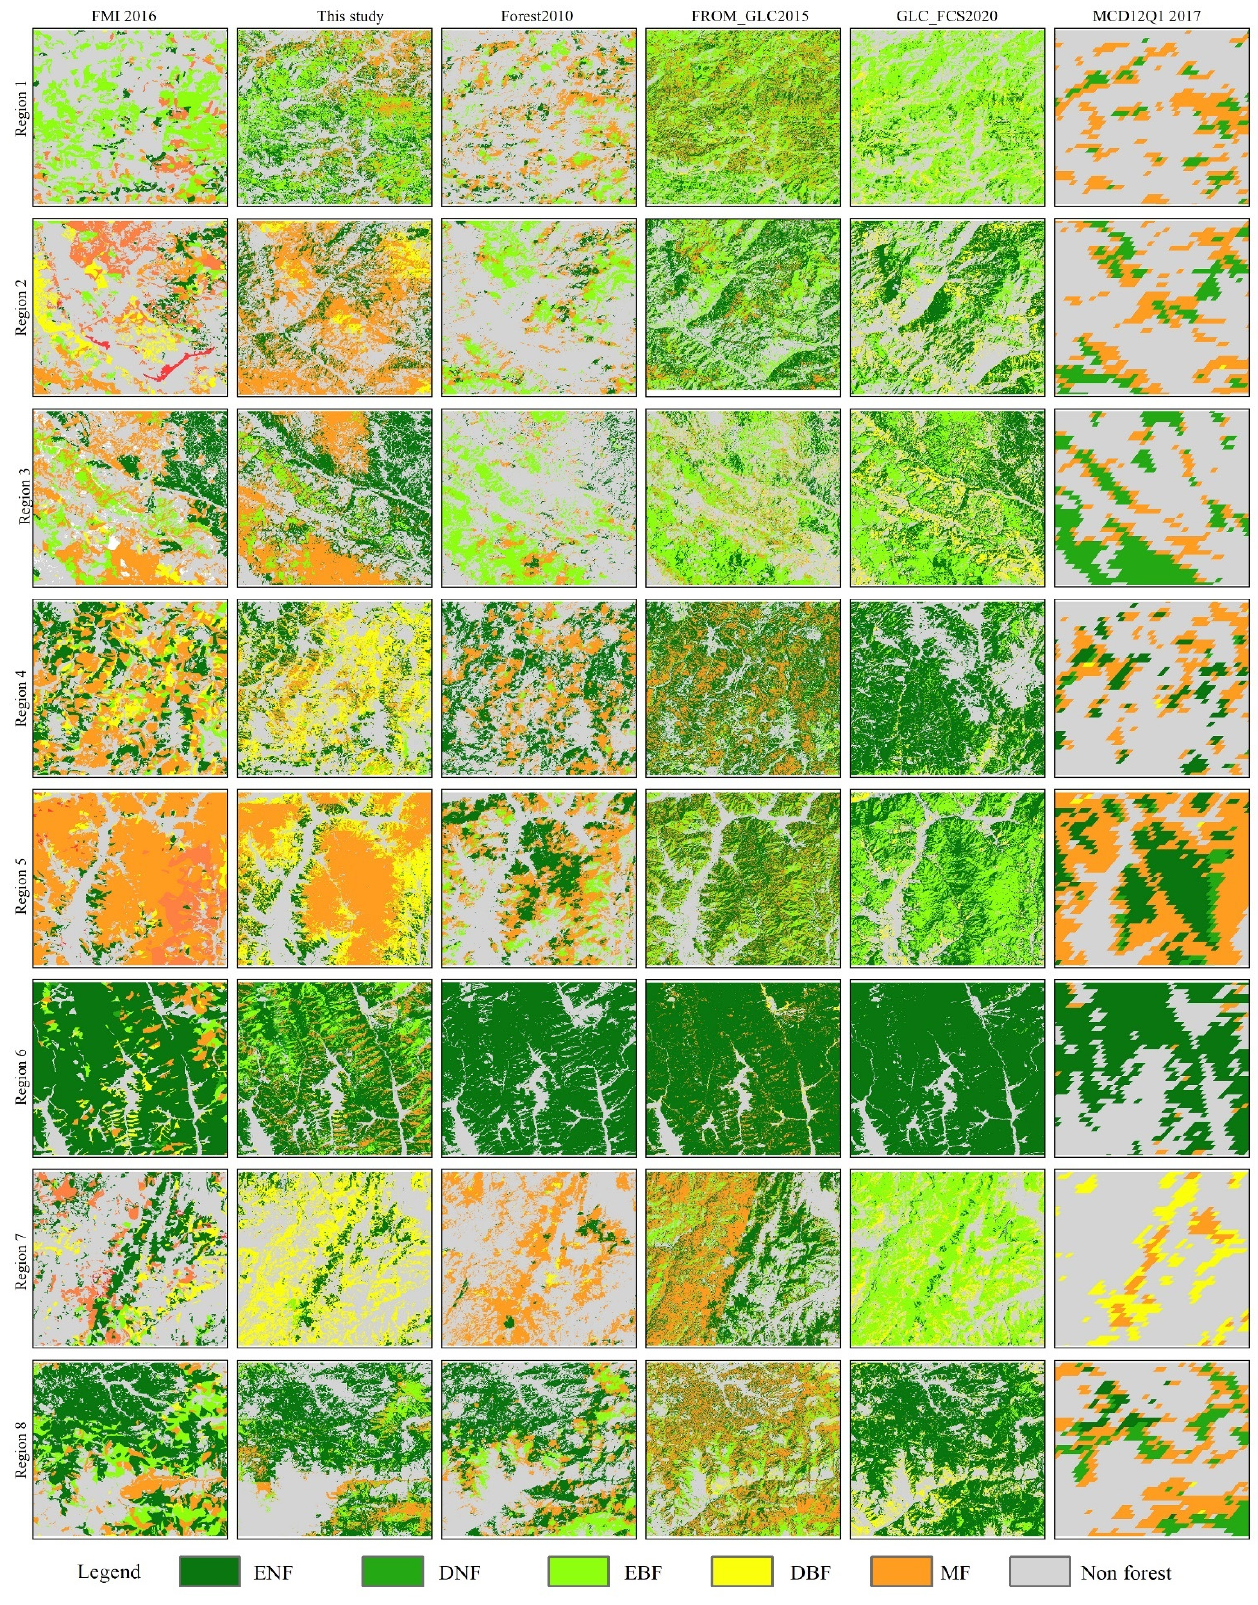
Figure 15. Local comparison for forest coverage developed by FMI, this study, Forest 2010, FROM_GLC2015, GLC_FCS 2020 and MCD12Q1 2017 in eight case regions. FMI: Forest management inventory.